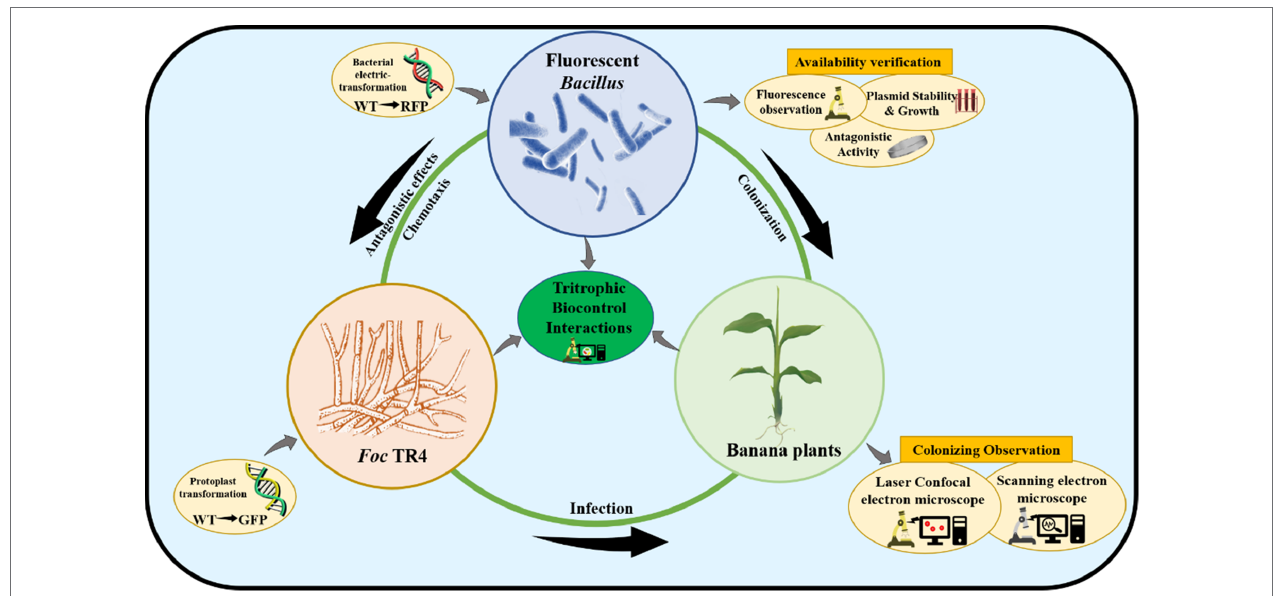
FIGURE 1 | The schematic diagram of tritrophic biocontrol